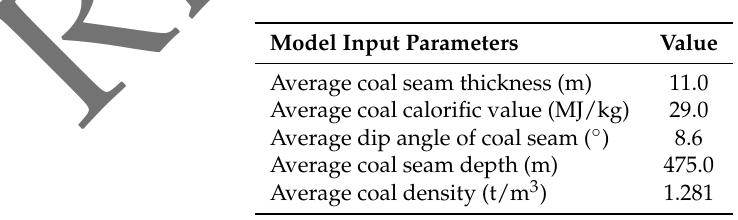
Table 1. Geological data of target coal seam, adapted from Otto et al.